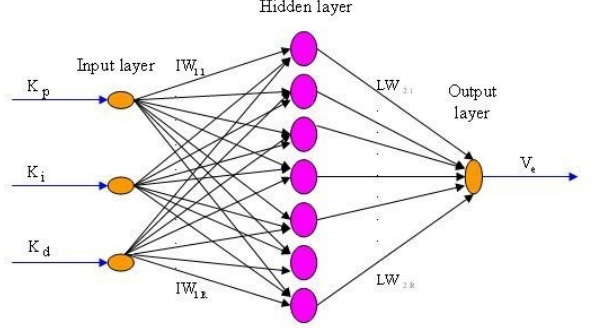
Figure 4. Layers of MLPFFNN.